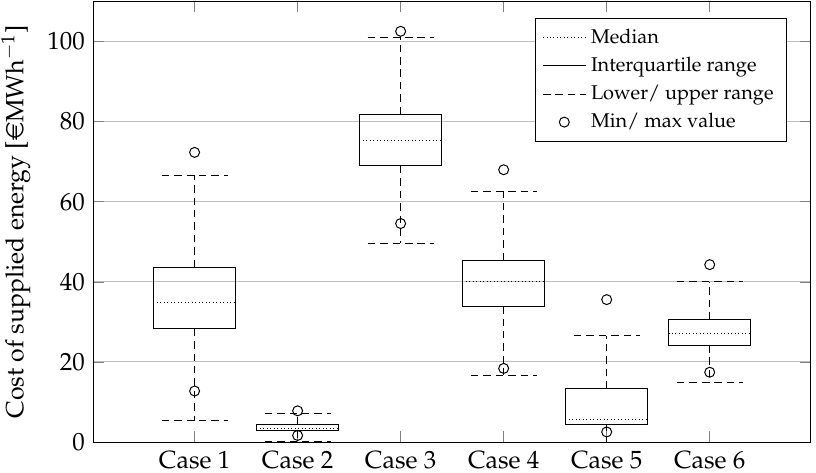
Figure 6. Box plot showing the costs for supplied energy for each case